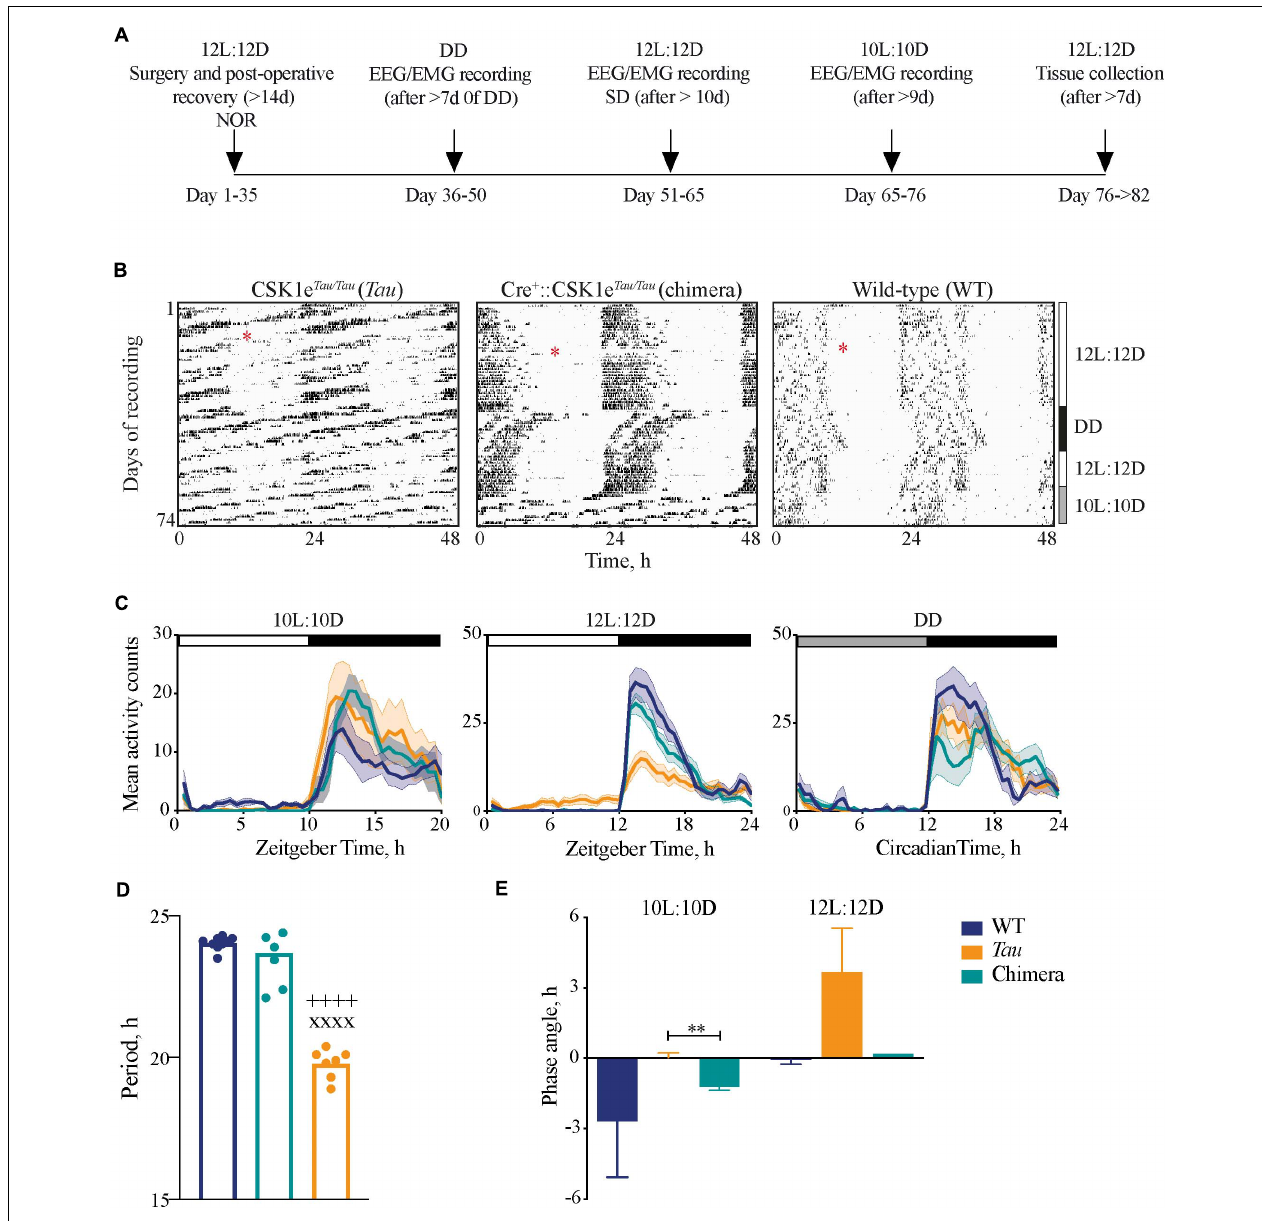
FIGURE 1 | Impact of circadian chimerism on locomotor activity. (A) Schematic showing the timeline of the experimental protocol (NOR, novel object recognition task; SD, sleep deprivation). (B) Representative double-plotted wheel-running actograms from Tau control (left), chimeric (middle) and WT (right) mice in LD (12L:12D and 10L:10D) and constant (DD) conditions, as indicated to the right. Surgery for implantation of telemetry device is denoted by the red asterisks. (C) Mean ( ± SEM) activity profiles of WT (blue), Tau (orange), and chimeric (green) mice in 10L:10D (left), 12L:12D (middle), and DD (right) ( n = 6–9). (D) Mean ( ± SEM) and individual periods of locomotor activity from WT (blue, n = 9), Tau (orange, n = 7), and chimeric (green, n = 7) mice in DD (1xANOVA post hoc Tukey’s multiple comparisons test xxxx p < 0.0001 Tau vs. WT, ++++ p < 0.0001 Tau vs. chimera). (E) Mean ( ± SEM) phase angle of entrainment to 10L:10D and 12L:12D photoschedules ( n = 6–7; unpaired t -test ** p < 0.005 Tau vs.